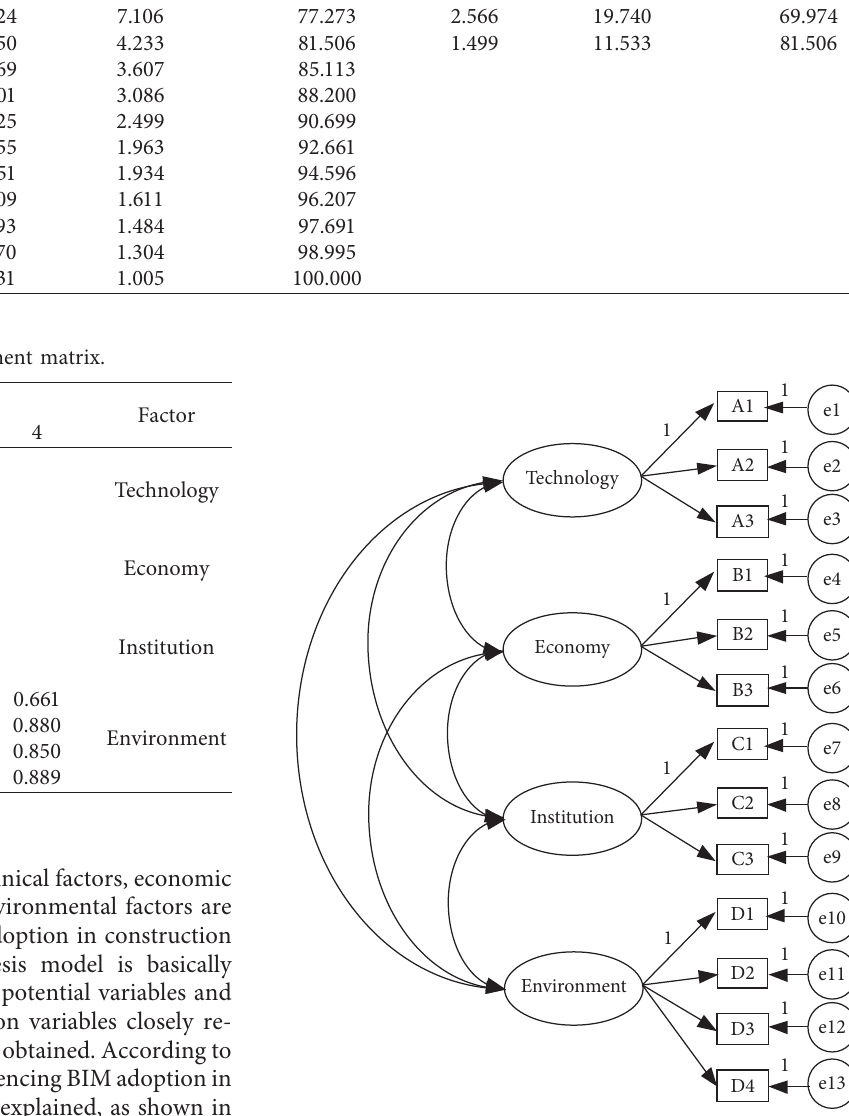
Figure 3: Structural equation model